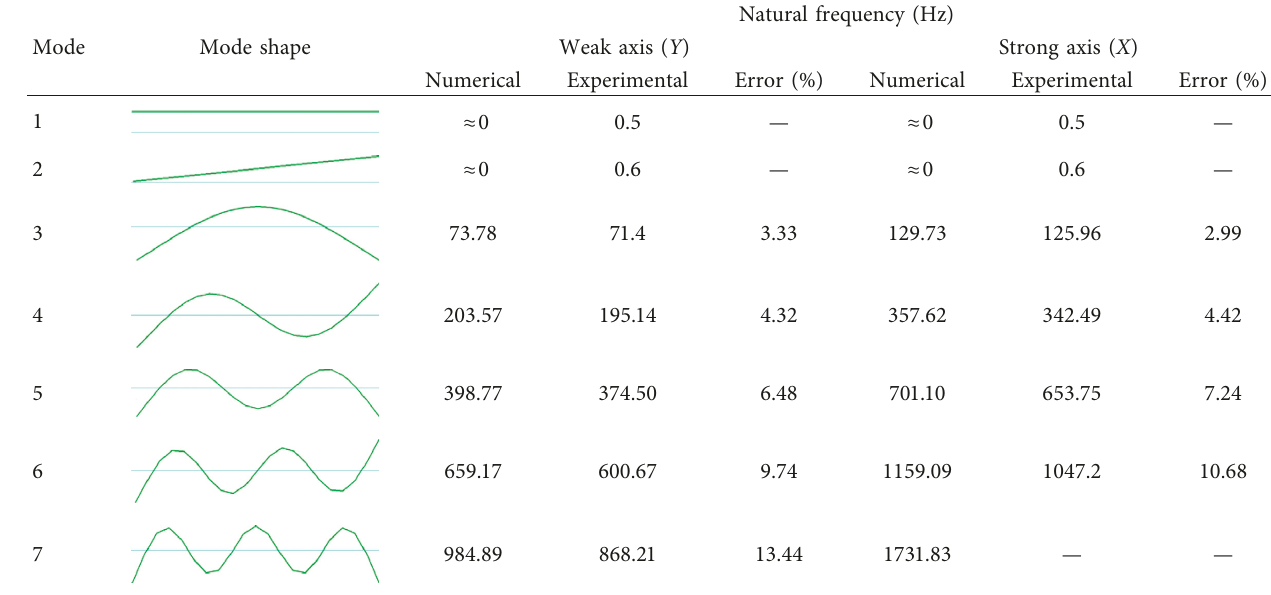
Figure 3: Singular value decomposition for the beam under free-free conditions from 0 to Table 2: Experimental and numerical natural frequencies for the free-free configuration.